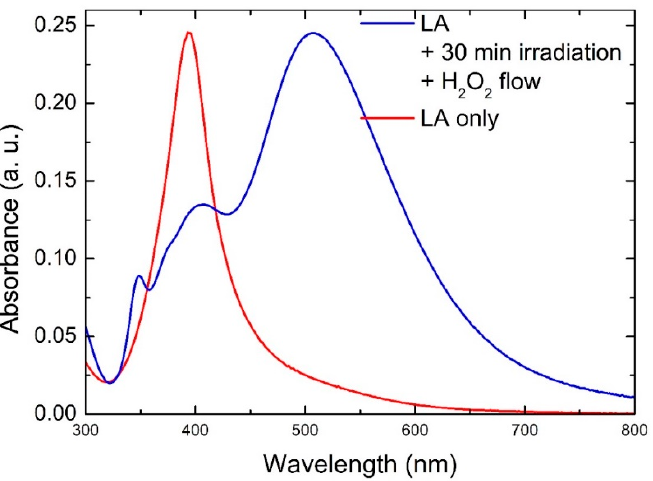
Figure 2. UV-Vis absorption spectra of Ag NPTs obtained by laser ablation under irradiation and H 2 O 2 flow (blue line) and Ag NPs obtained by laser ablation only (red line).